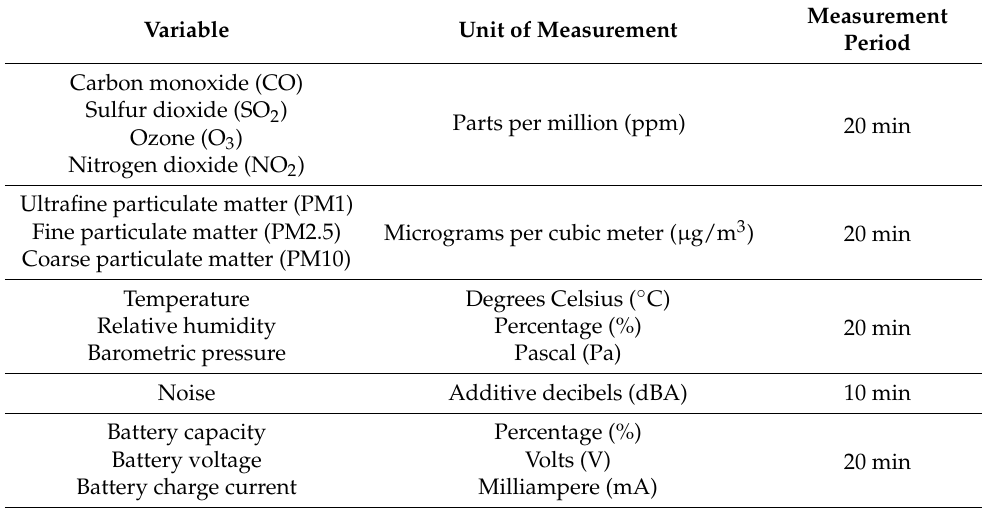
Table 1. Environmental variables with the unit and period in which they are